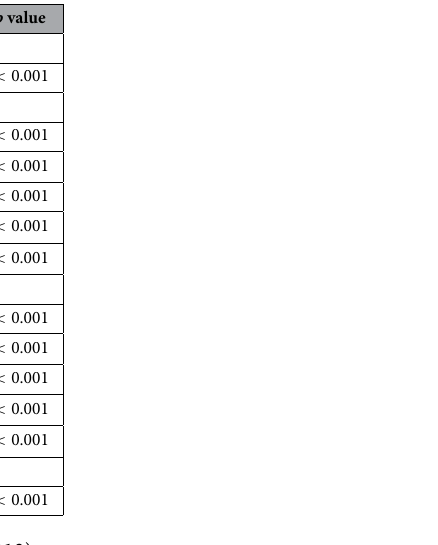
Table 2. MLEs of the parameters (log-likelihood: −